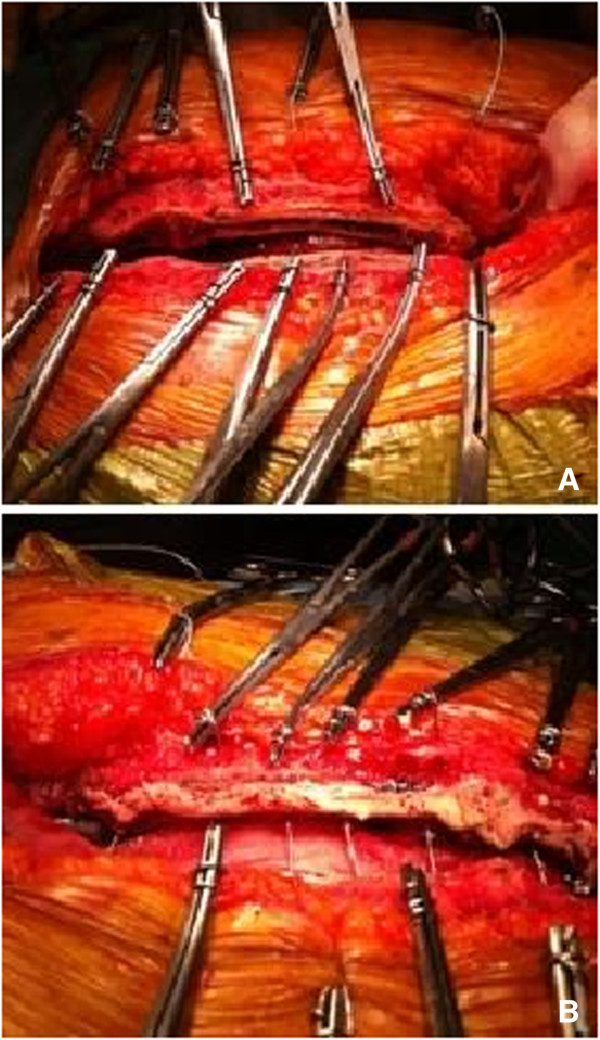
Severely osteoporotic sternum (A); application of Kryptonite bone cement (B).